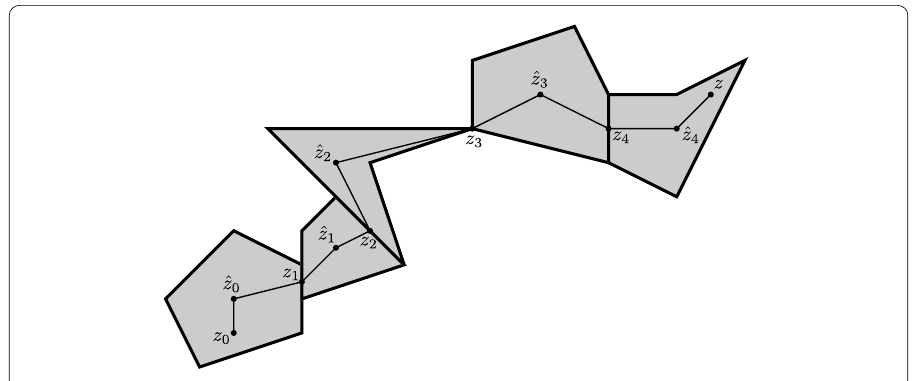
Figure 4 Sets S 0 , ... , S 4 in a valid subdivision, reference points, and path used for proof of Lemma